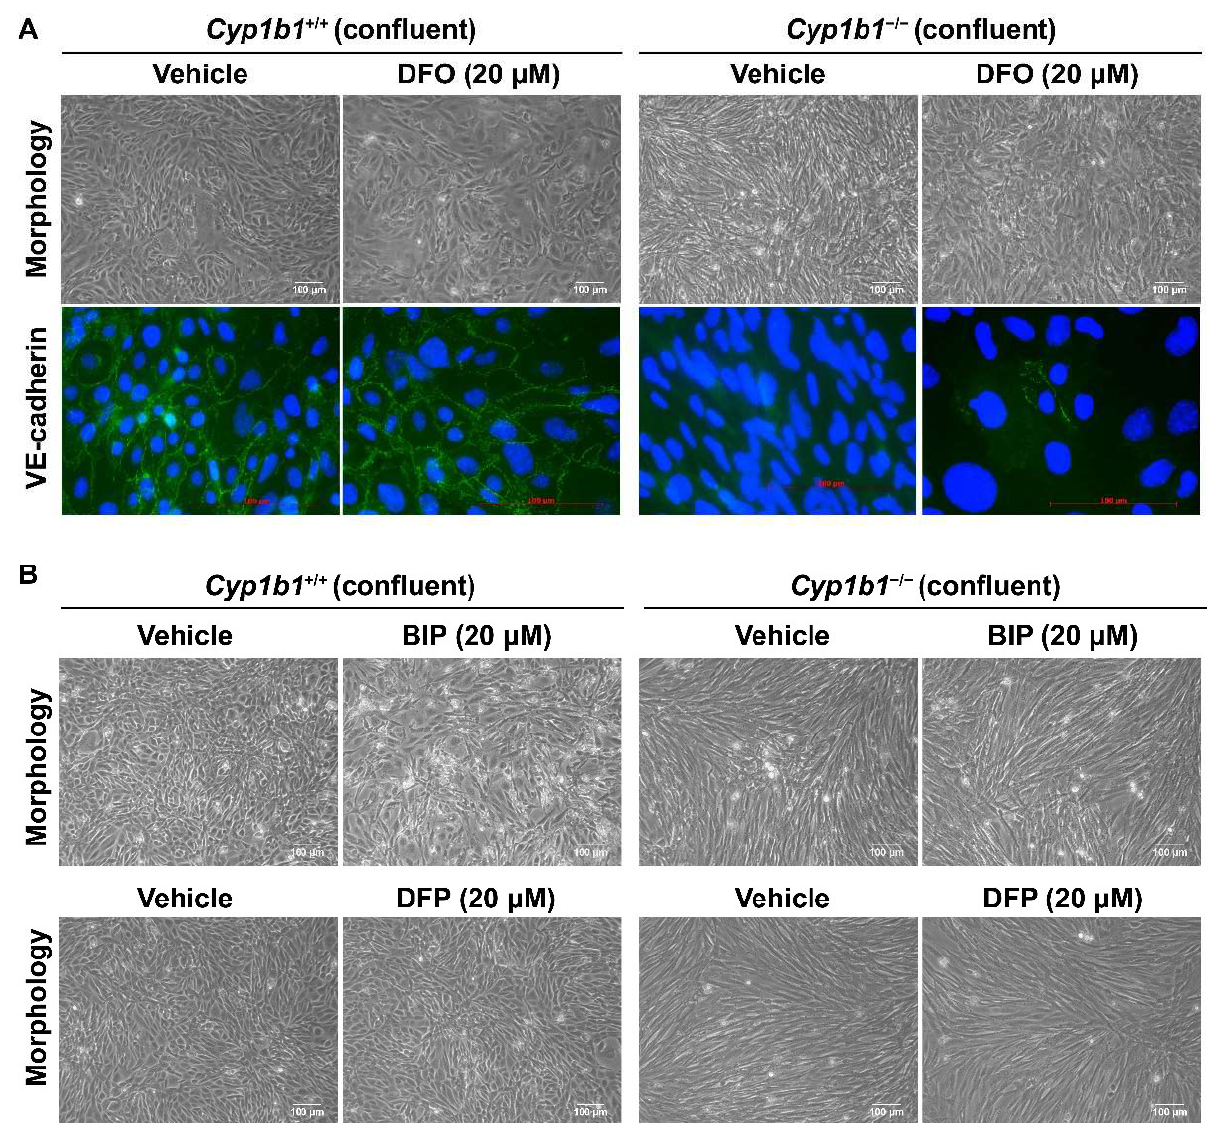
Figure 5. Altered confluent cell morphology and lack of VE-cadherin junctional localization in C yp1b1 −/− retinal ECs were partially restored by iron chelator DFO, and not by deferiprone (DFP) or 2,2’-Bipyridine (BIP). ( A ) Near-confluent (90%) Cyp1b1 +/+ and C yp1b1 −/− retinal ECs were incubated with 20 µM DFO for 48 h. The cell morphology was assessed by phase microscopy and stained with anti-VE-cadherin antibody (labeled green) to determine the junctional localization of VE cadherin (scale bars = 100 µM). DAPI (blue) was used to stain the cell nuclei. Please note the partial restoration of morphology and VE-cadherin junctional localization in C yp1b1 −/− retinal ECs incubated with DFO. ( B ) Near-confluent (90%) Cyp1b1 +/+ and C yp1b1 −/− retinal ECs were incubated with 20 µM BIP or DFP for 48 h. The cell morphology was assessed by phase microscopy and photographed in digital format (scale bars = 100 µM). Please note no dramatic changes in morphology of C yp1b1 −/− retinal ECs incubated with BIP or DFP.